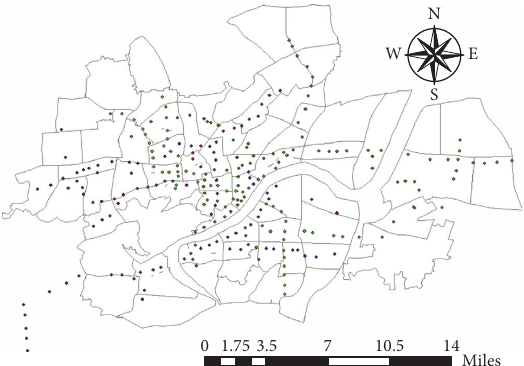
Figure 7: Subway stations in Hangzhou by